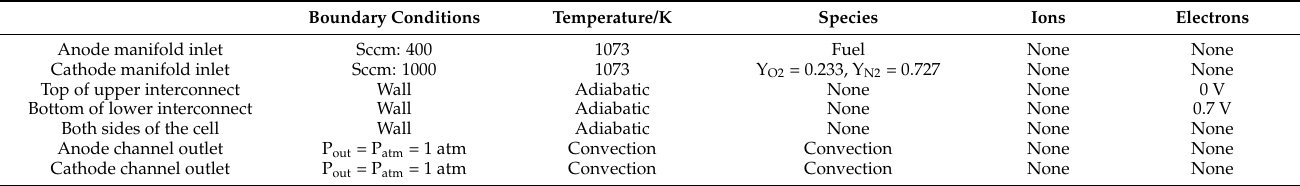
Table 6. Major boundary conditions and input parameters of SOFC